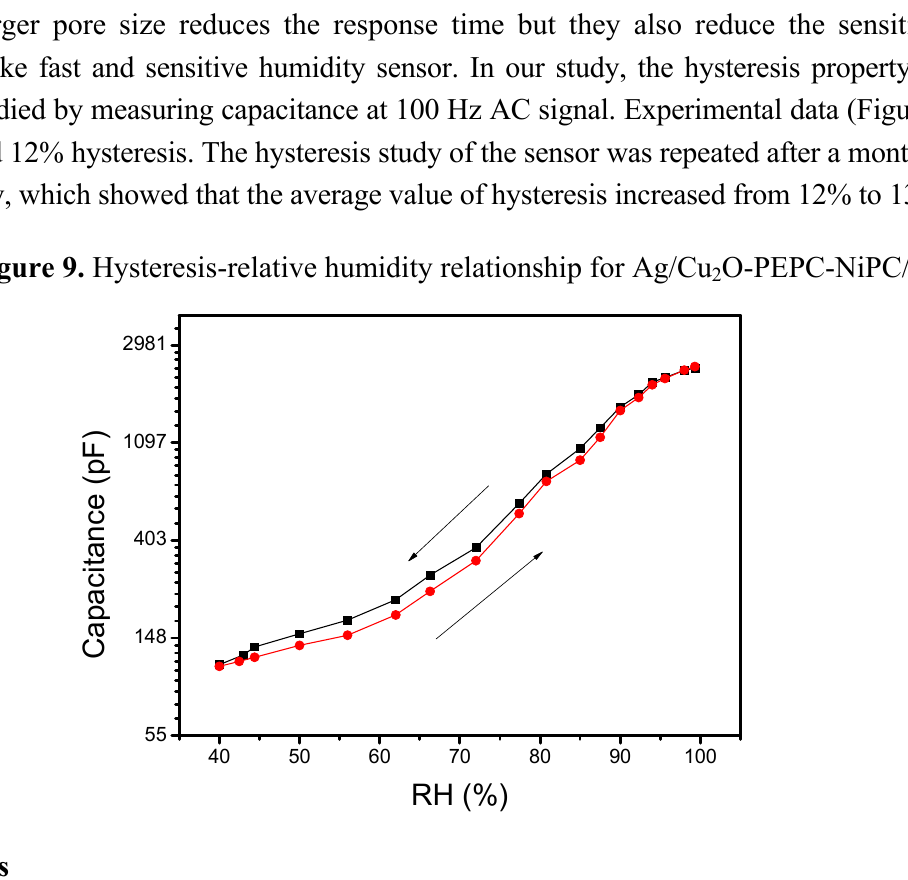
Figure 9. Hysteresis-relative humidity relationship for Ag/Cu